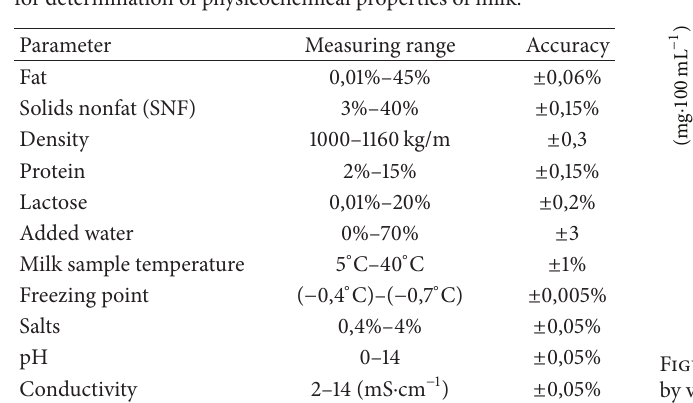
Table 1: Capability and accuracy of milk by ultrasonic milk analysis for determination of physicochemical properties of milk.